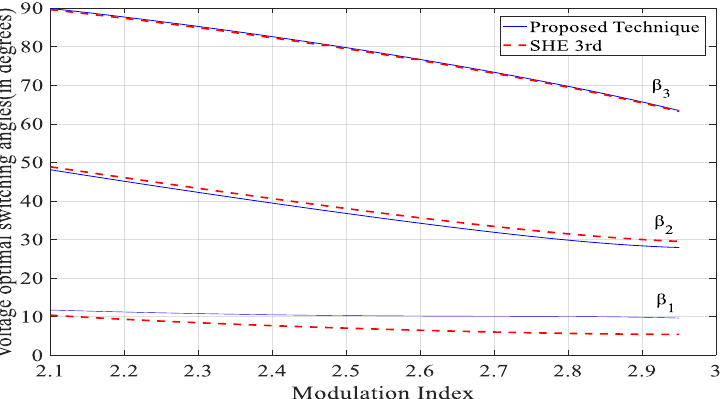
Figure 6. FFT analysis for 3rd order harmonic elimination at 𝑚 = 2.52 using ( a ) the proposed tech- nique and ( b ) the conventional technique.